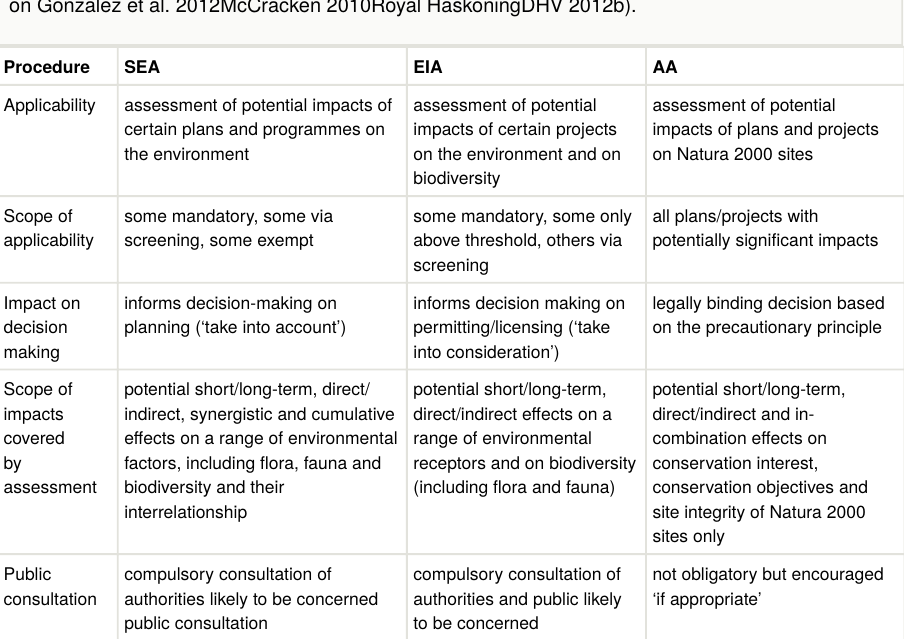
use of biodiversity data in spatial planning and impact assessment